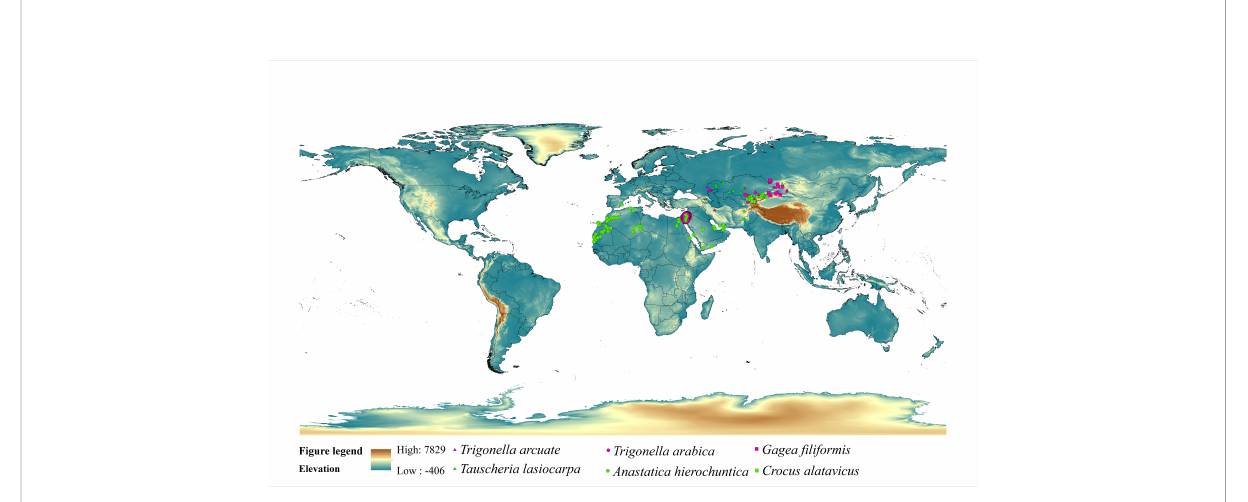
FIGURE 2 Area under the curve values of six ephemeral plants.